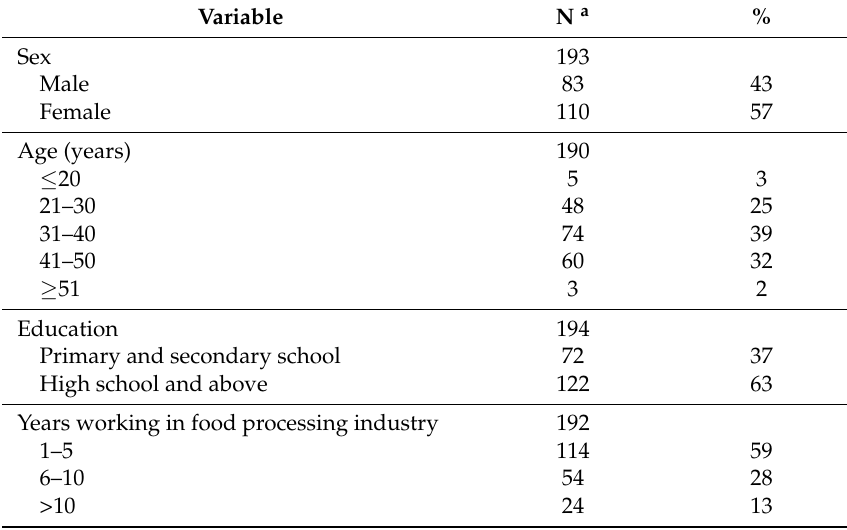
Table 1. Demographic characteristics of the respondents.